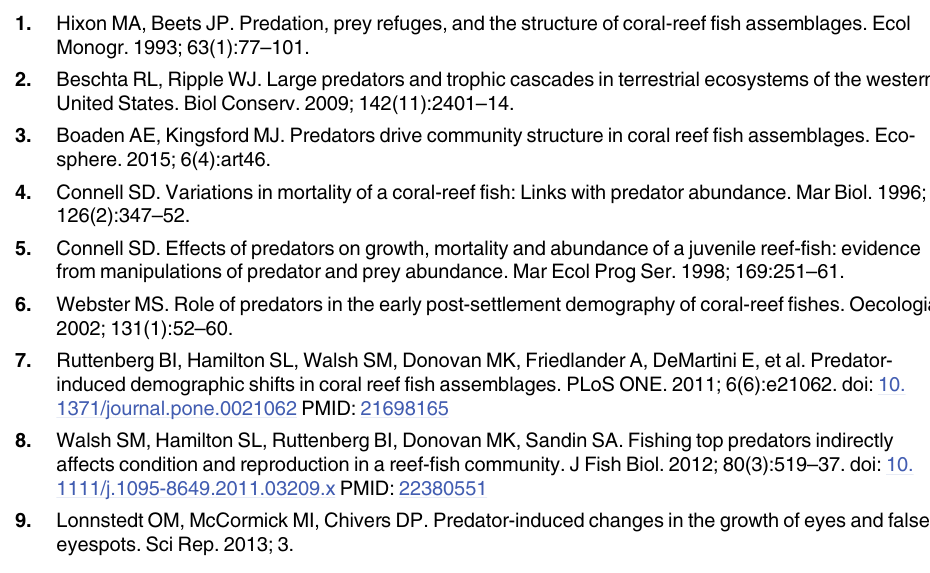
S1 Fig. Diagram of experimental setup, showing placement of the smaller experimental tank inside the larger flow-through holding